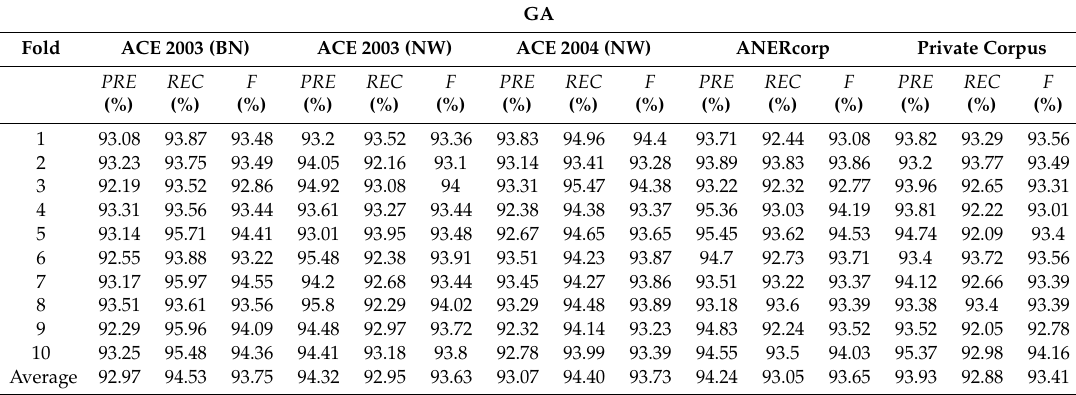
Table A2. Performance evaluation of ontology learning using the GA over the five corpora.